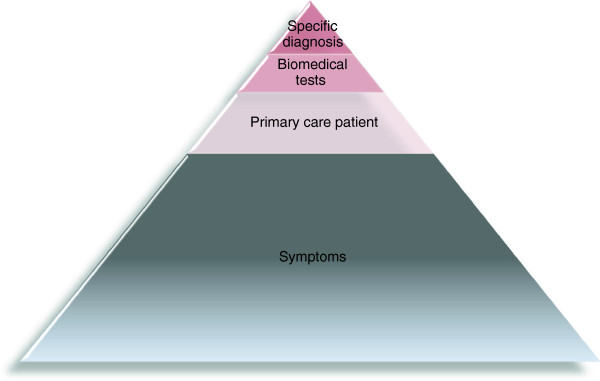
The symptom iceberg.